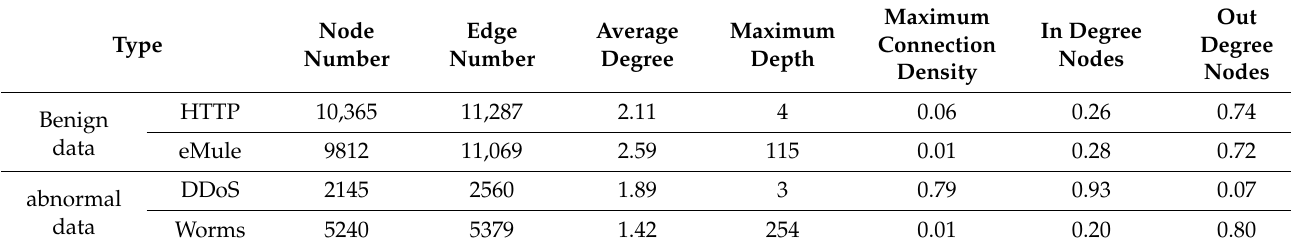
Table 3. Feature representation of raw TIAG.